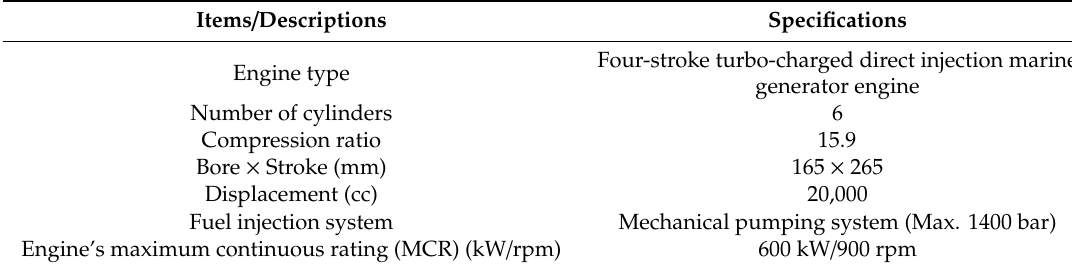
Table 1. Specifications for the test